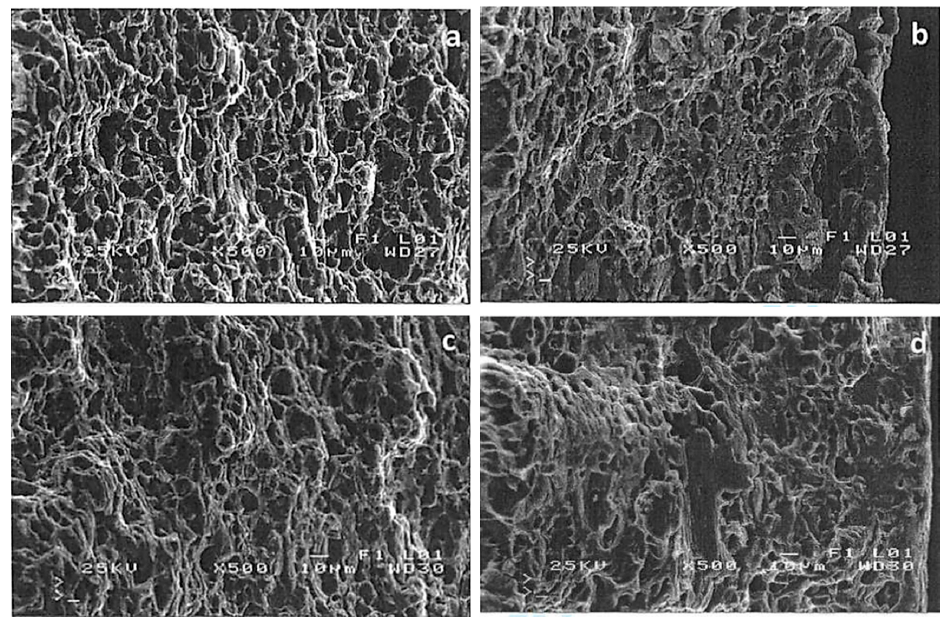
Figure 4. SEM analysis of the fractured surface of T6 treated 6082 aluminum alloy, after SSRT testing in ( a ) air, ( b ) pH = 3, ( c ) pH = 7 and ( d ) pH = 10.